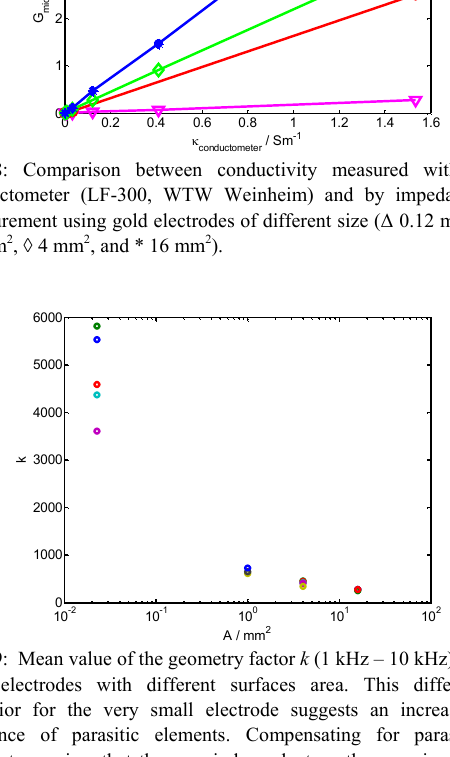
Fig.20: Molar conductivity vs. square root of the concentration for gold electrodes of different size ( (cid:184) 0.125 mm 2 , x 1 mm 2 , o 4 mm 2 , (cid:507) 16 mm 2